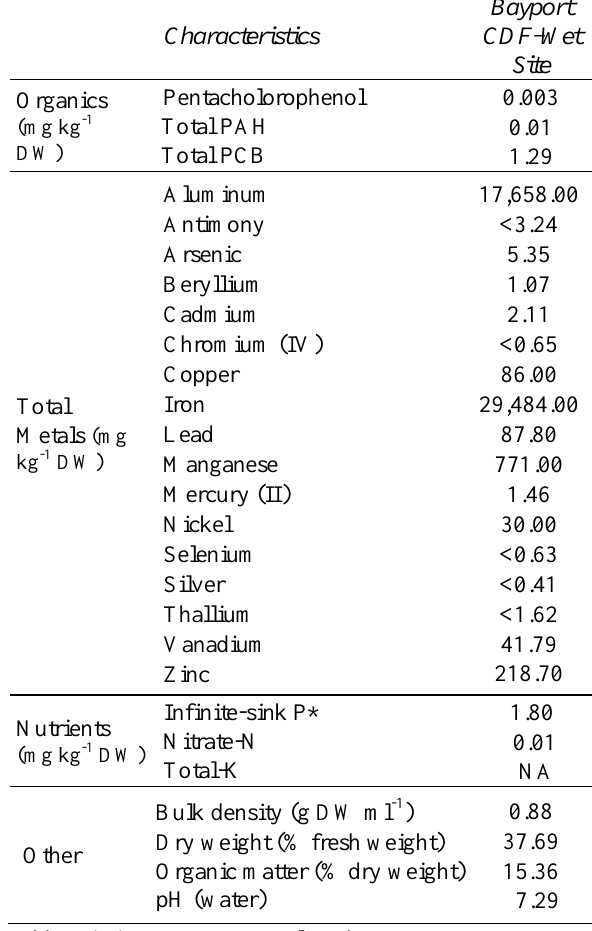
Table 2: Bayport dredged material profile